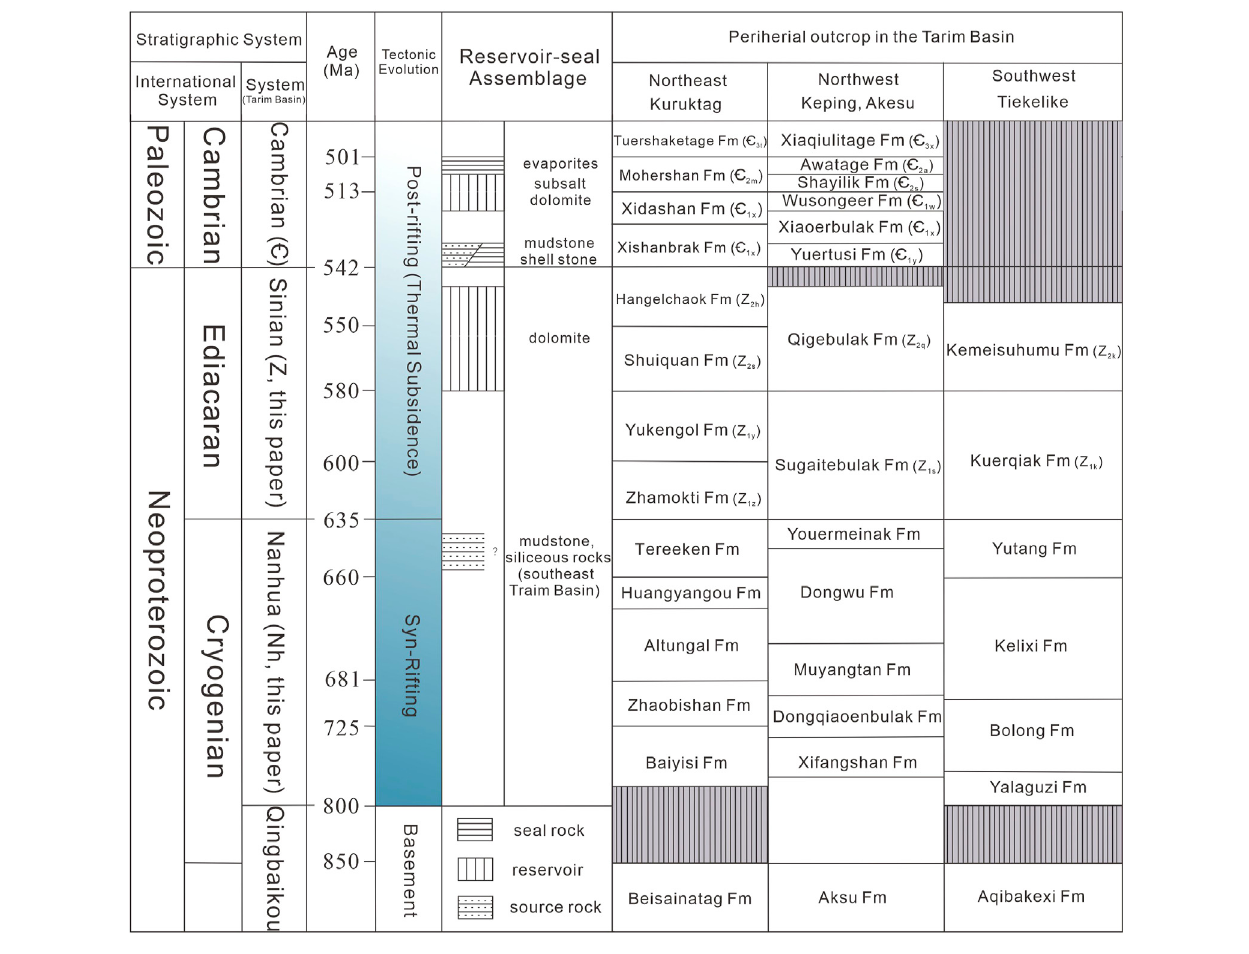
Frontiers in Earth Science |